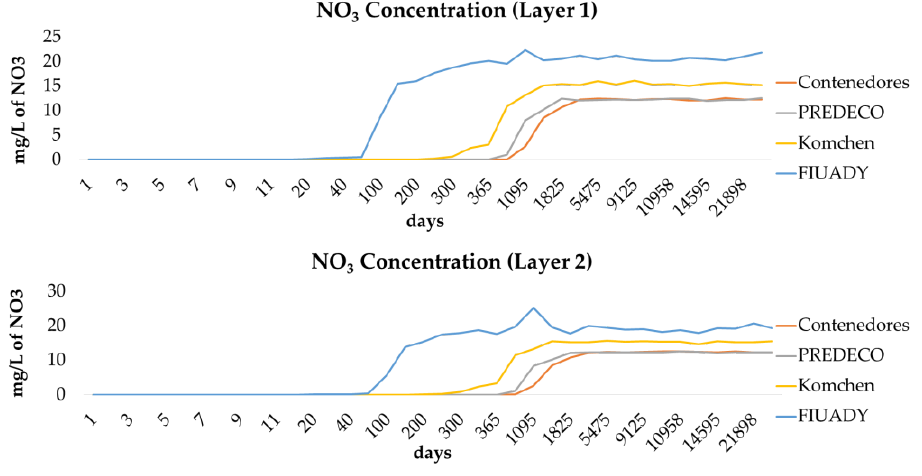
Figure 9. NO 3 concentration curves for layers 1 and 2 for selected observation wells along the Merida-Progreso transect. The minimum NO 3 concentration, according to the Mexican standards for water supply, is 10 mg/L (NOM-127-SSA1-1994).